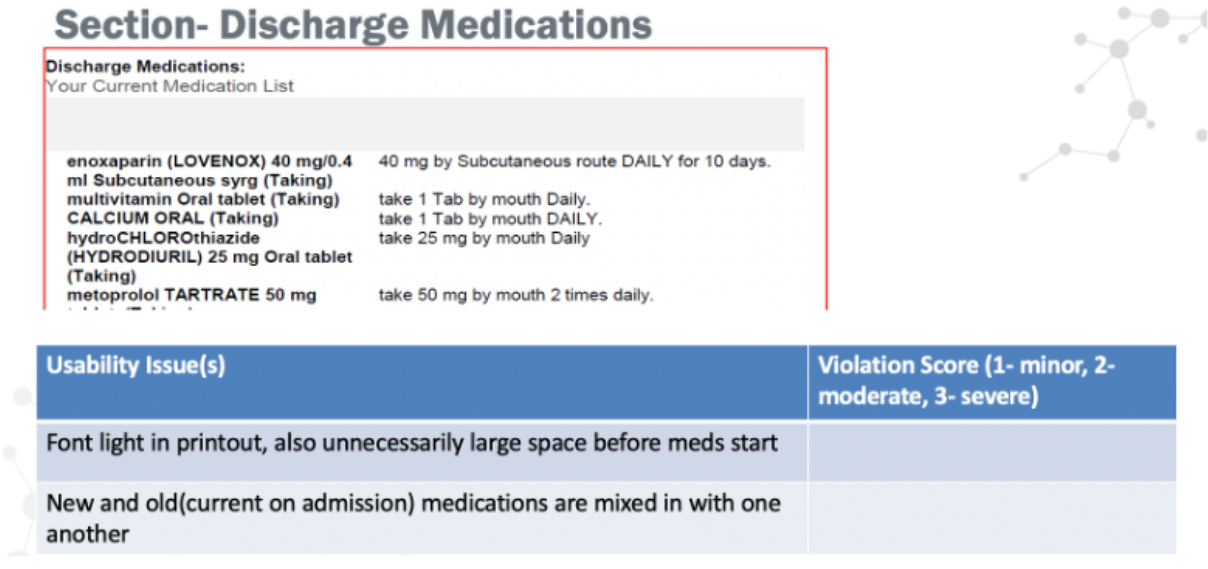
Figure 3. Screenshot of a slide used to summarize potential issues found by the human factors team.